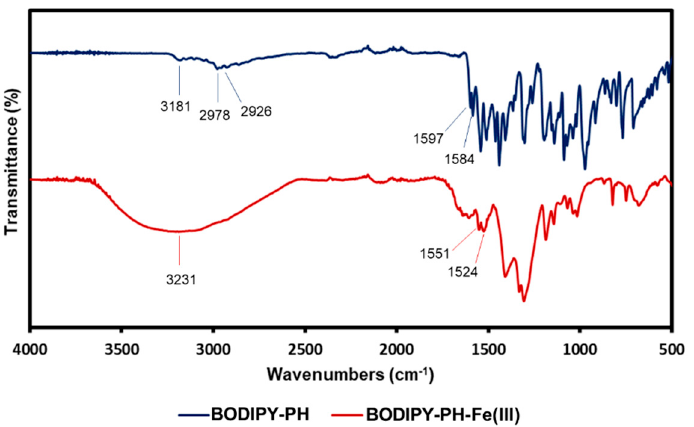
Figure 8. Fourier transform infrared spectroscopy (FTIR) spectra of BODIPY-PH (blue line) and BODIPY-PH-Fe 3+ (red line).